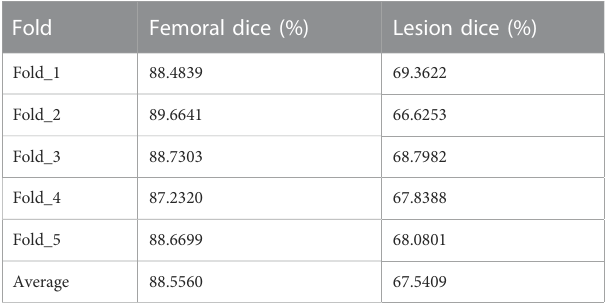
TABLE 3 Five-fold cross-validation results of the U-Net backbone network.